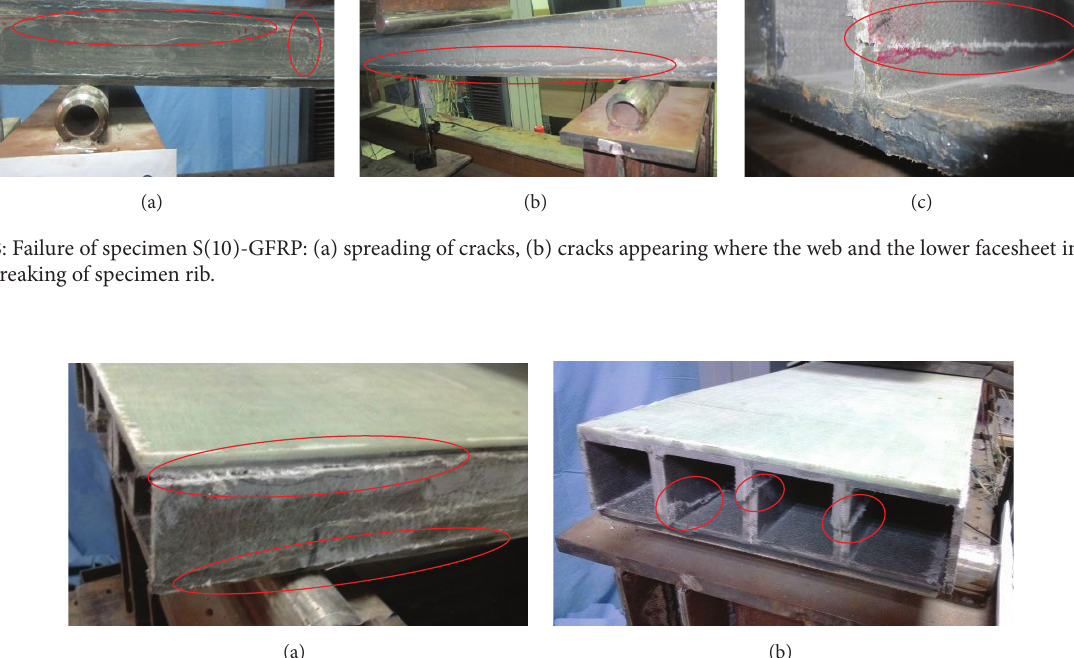
web on the other side also peeled off from the lower